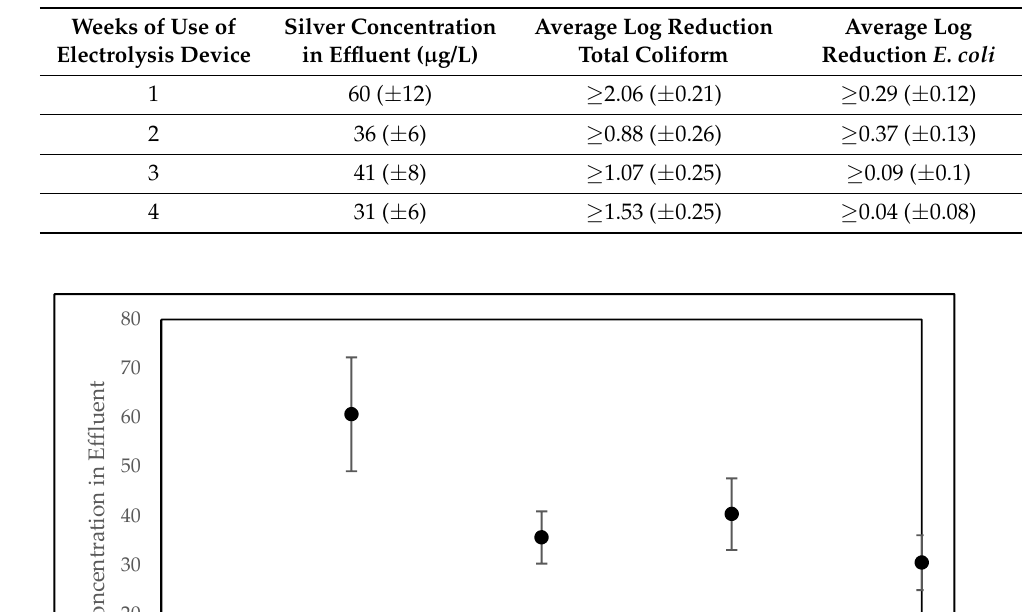
Figure 13. Box and whisker plot of total coliform bacteria concentration in water taken from the home and intervention spigot over four weeks. ( a ) displays the log of total coliform bacteria